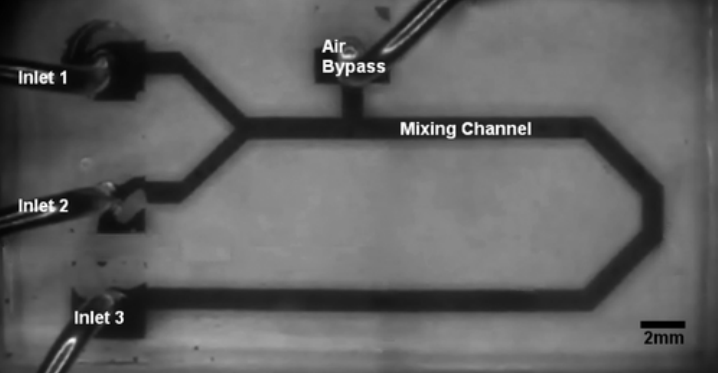
Figure 28. A microchannel mixer with an air-inlet port to produce isolated droplets for better mixing (from Rhee and Burns